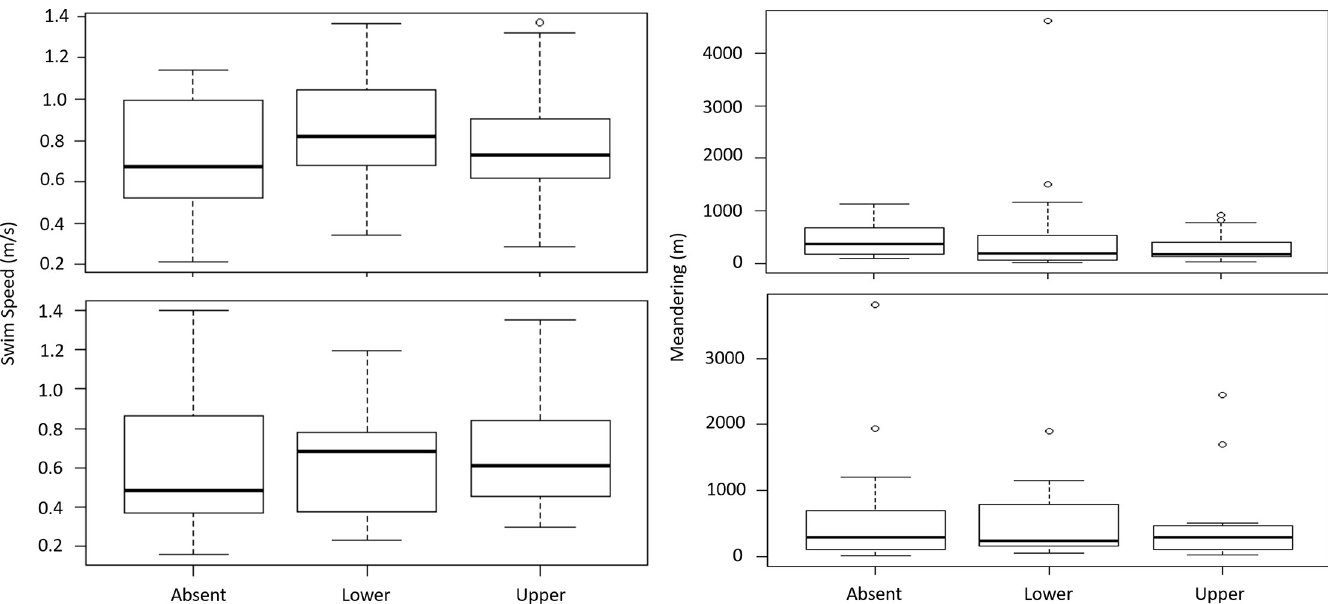
Fig 9. Left boxplots show swim speed (meters per second) and right boxplots show meandering (difference in actual swim path from a linear swim path) when the dredge was not in the area (Absent), when the dredge was working in the lower area (Lower) and when the dredge was working in the upper area (Upper). The top boxplots are when Atlantic sturgeon where swimming upstream through the study area while the bottom boxplots are when Atlantic sturgeon were swimming downstream through the study area. Permutation tests showed no significant difference between swim speed and dredge location for upstream movements (p = 0.429) and dredge location for downstream movements (p = 0.756). Permutation tests also showed no significant difference between meandering and dredge location for upstream movements (p = 0.44) and for dredge location and downstream movements (p = 0.96).